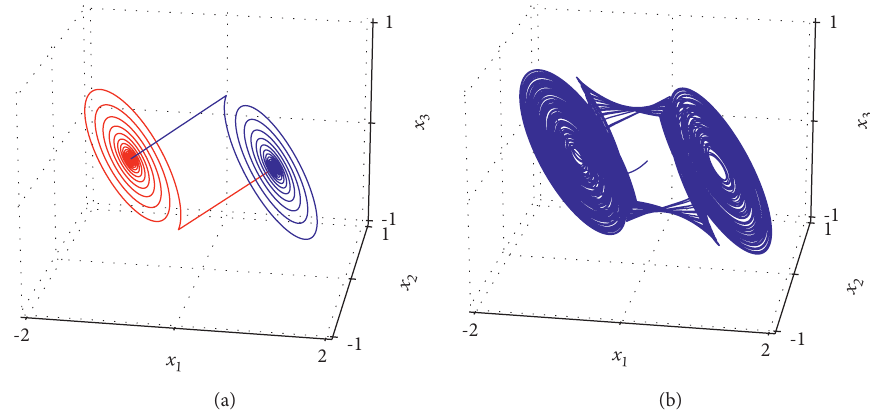
− x � 0 􏼈 􏼉 , the parameters 1 3